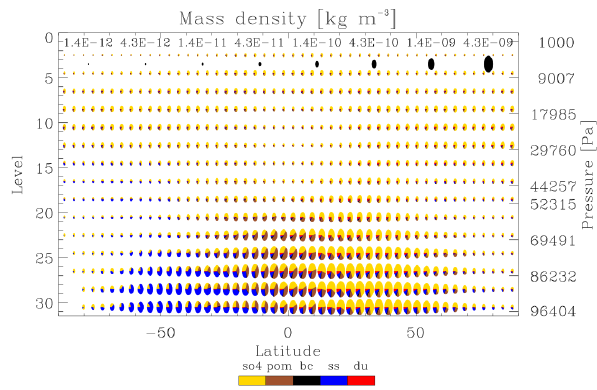
Figure 16. Zonal distribution of annual densities of the hydrophilic accumulation mode. The colors indicate species (defined in Ta- ble 3). The pie chart shows fractional contributions, while the radius of the pie indicates the zonally averaged density (logarithmic scale as shown in black at the